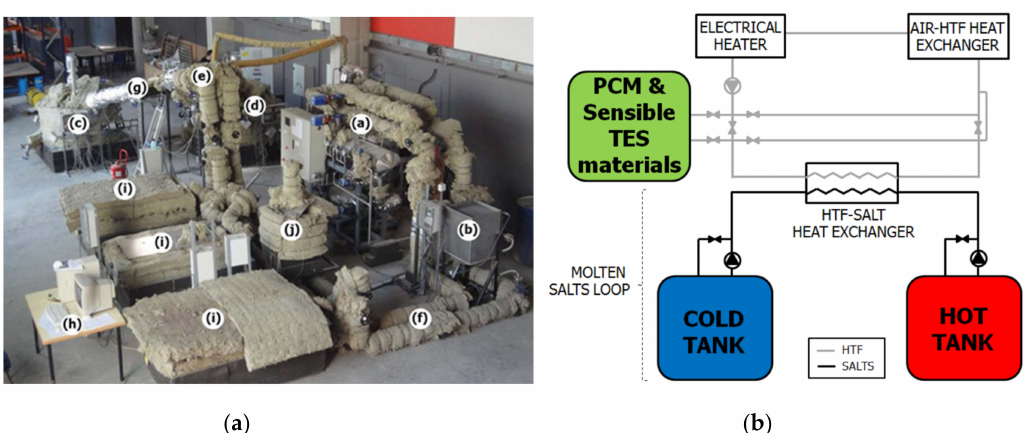
Figure 17. ( a ) Picture and ( b ) scheme of stability testing device “UDL-GREiA II” (reproduced with permission from [46], University of Lleida, 2017). The letters in the figure ( a ) correspond to: (a) electrical heater, (b) air–heat transfer fluid (HTF) heat exchanger, (c) hot tank, (d) cold tank, (e) plate heat exchanger HTF–molten salt, (f) HTF loop, (g) molten salt, (h) acquisition and recording system, (i)